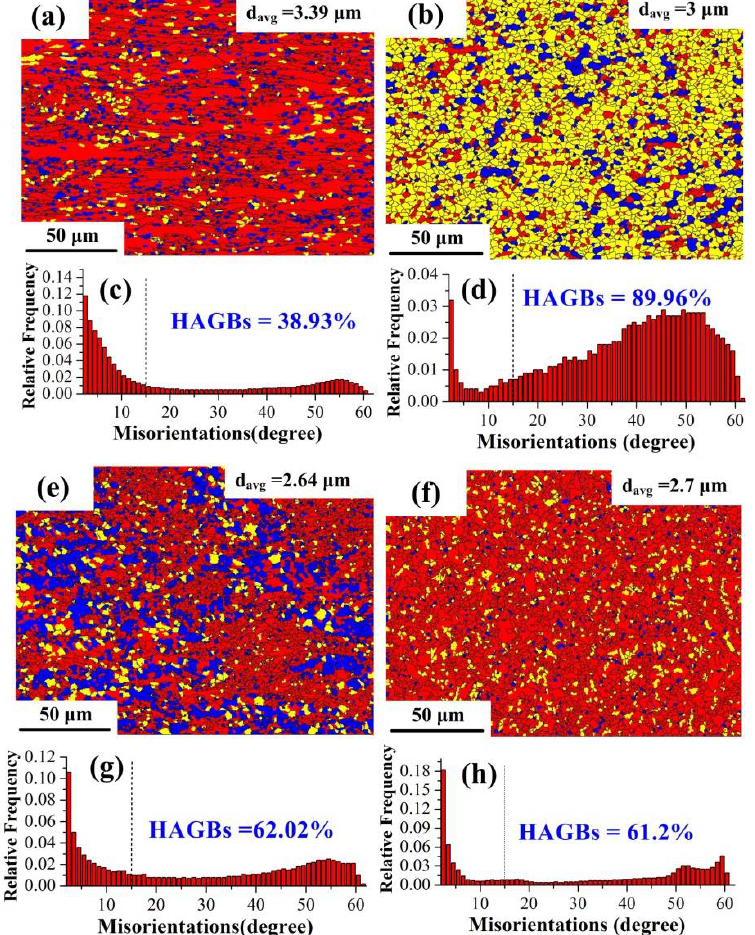
Figure 7. EBSD maps of recrystallized, substructure, and deformed grains, and misorientation angle distributions( a , c ) 750 °C, 1 s − 1 ;( b , d ) 800 °C, 1 s − 1 ; ( e , g ) 800 °C, 10 s − 1 ; ( f , h ) 850 °C, 10 s − 1 .